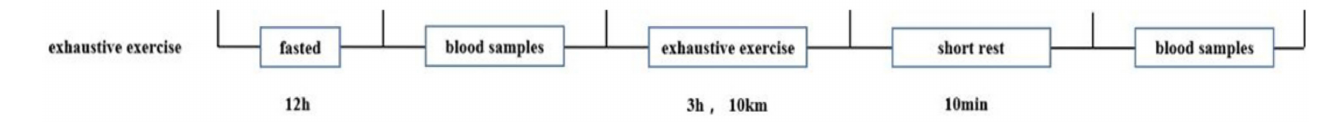
Figure 1. Exhaustive exercise experimental